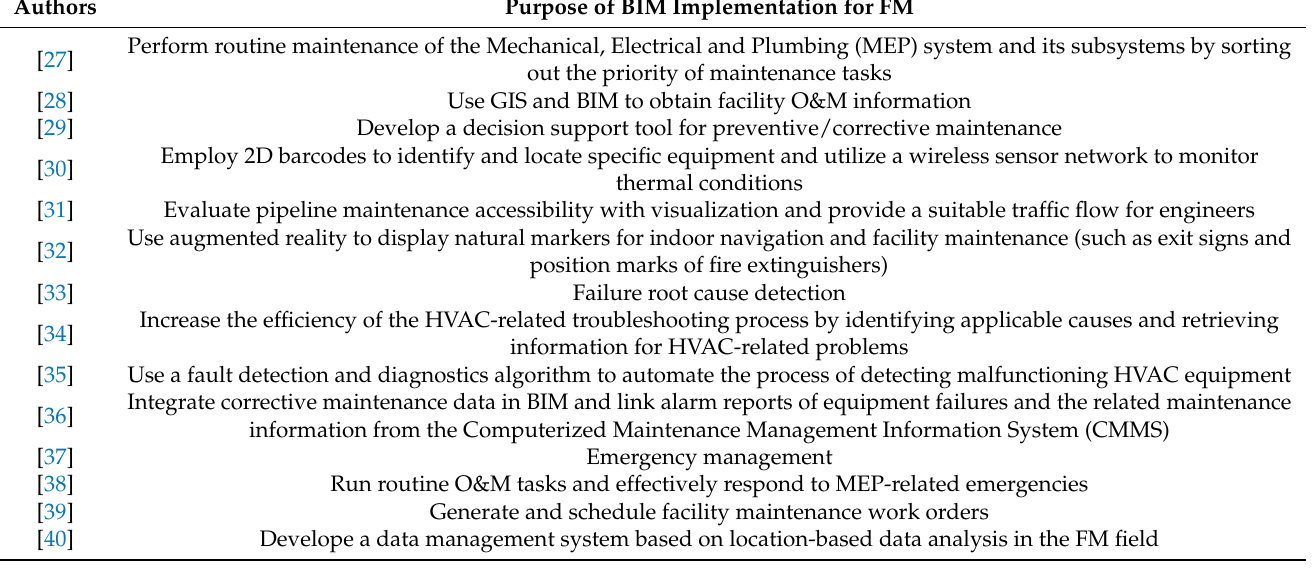
Table 1. Example studies with specific purposes of BIM implementation for